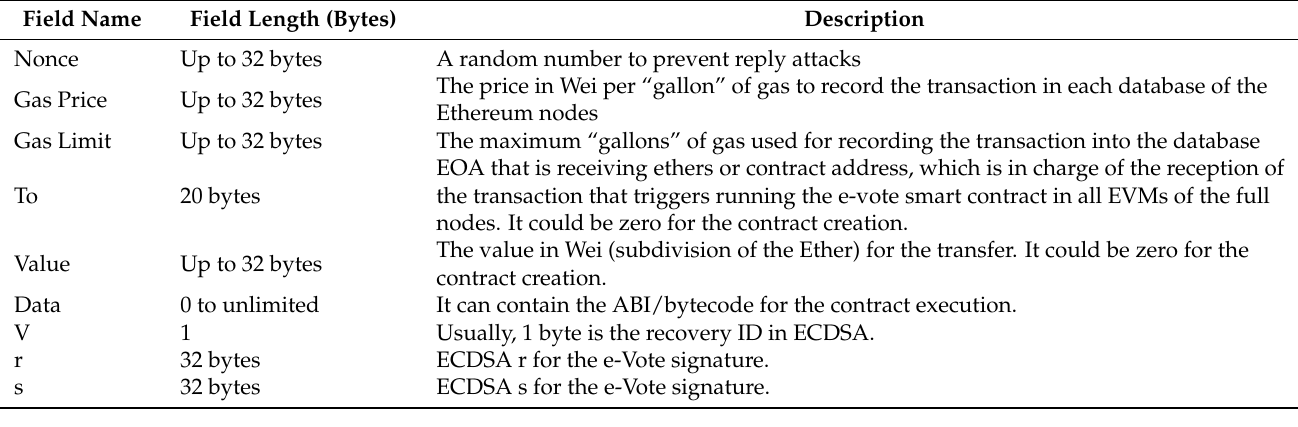
Table 1. Ethereum Transaction Structure.